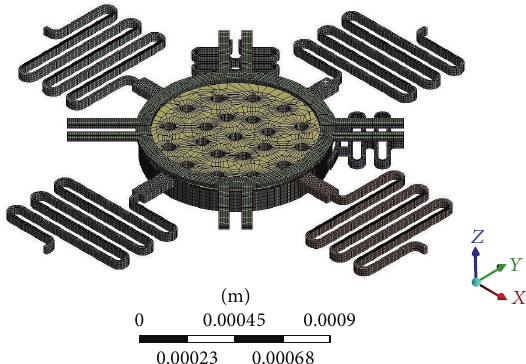
Figure 7: FE model of the switch.